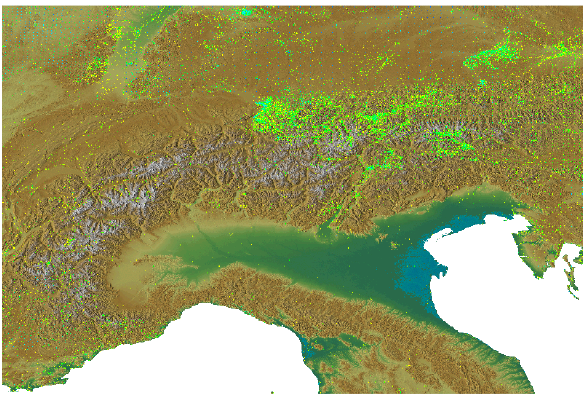
Figure 3: Plant occurrences and topography in the Alps region (Europe). Plant occurrences extracted from GBIF data (web- site accessed Dec 2014). Light green points (observations from GBIF) follow valleys within Alps, i.e. the most accessible